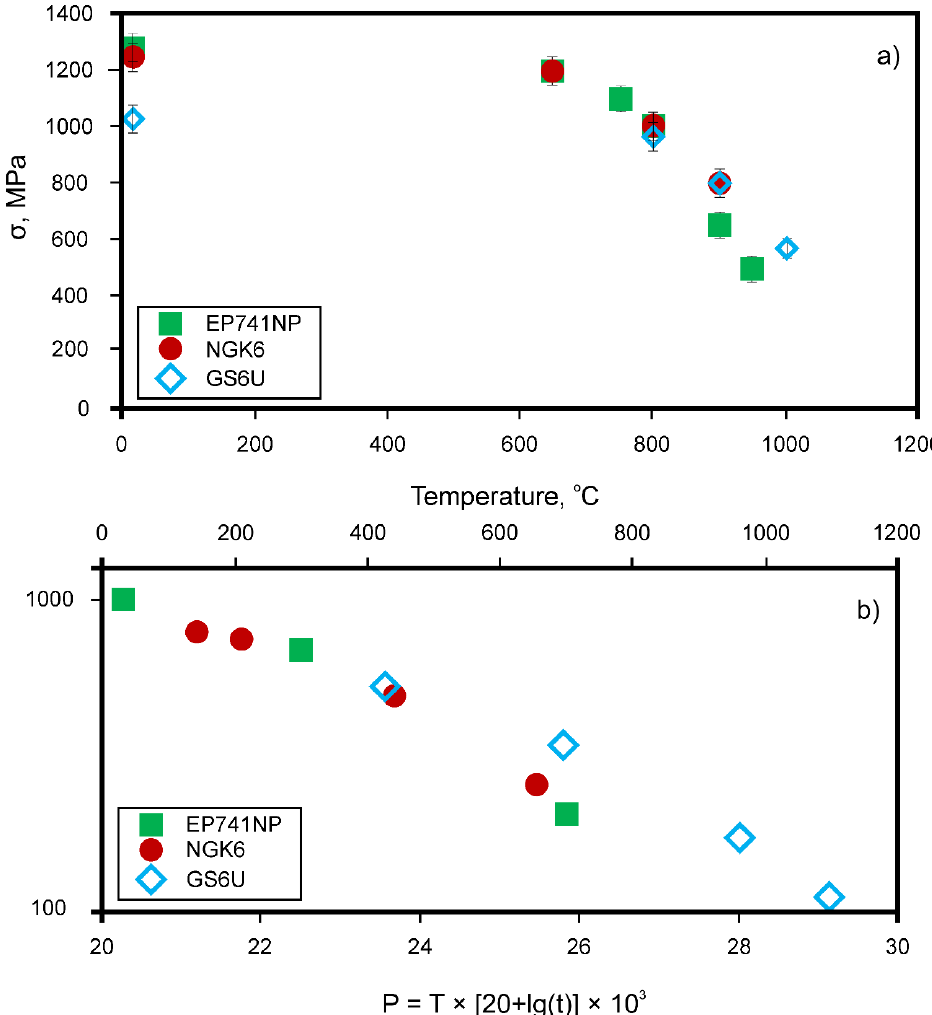
Figure 9. Mechanical testing of the Ni-based superalloys: tensile strength as a function of temperature ( a ), and the long-term strength as a Larson-Miller diagram ( P = T [20 + log( t )] × 10 3 ) ( b ); powder NGK-6 (circles), cast GS6U (triangles) and powder EP741NP (diamonds) [12]. Copyright 2015 Elsevier. The indicators of the long-term strength of the alloys are shown in Figure 9b in the form of a Larson-Miller diagram ( P = T [20 + log( t )] × 10 3 ). The diagram shows that at high temperatures T and long life t (large values of the P parameter), the experimental NGK-6 powder alloy tends to have better creep resistance than the well-known EP741NP powder alloy.